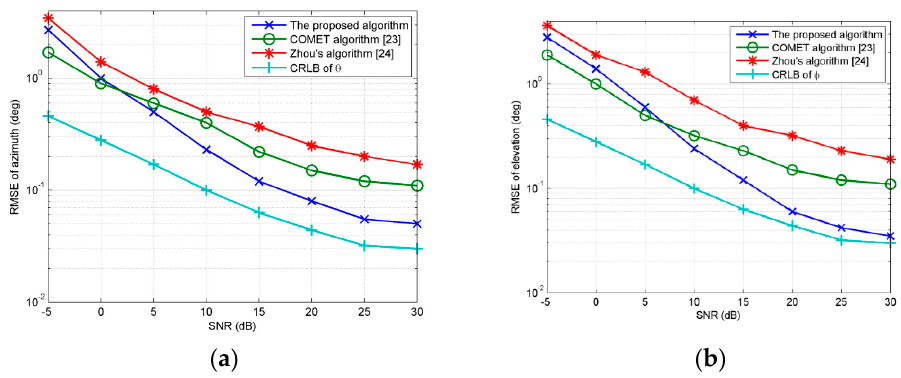
Figure 2. ( a ) RMSE θ estimated by three algorithms for 2D ID sources vesus SNR ; ( b ) RMSE ϕ estimated by three algorithms for 2D ID sources vesus SNR .